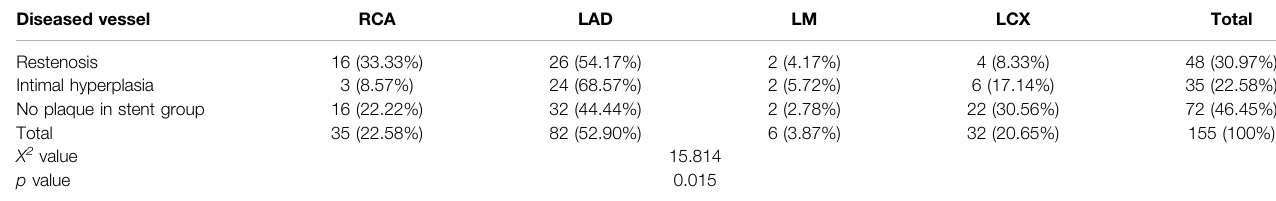
TABLE 8 | Pearson correlation between diseased vessels and the severity of in stent restenosis. Diseased vessel